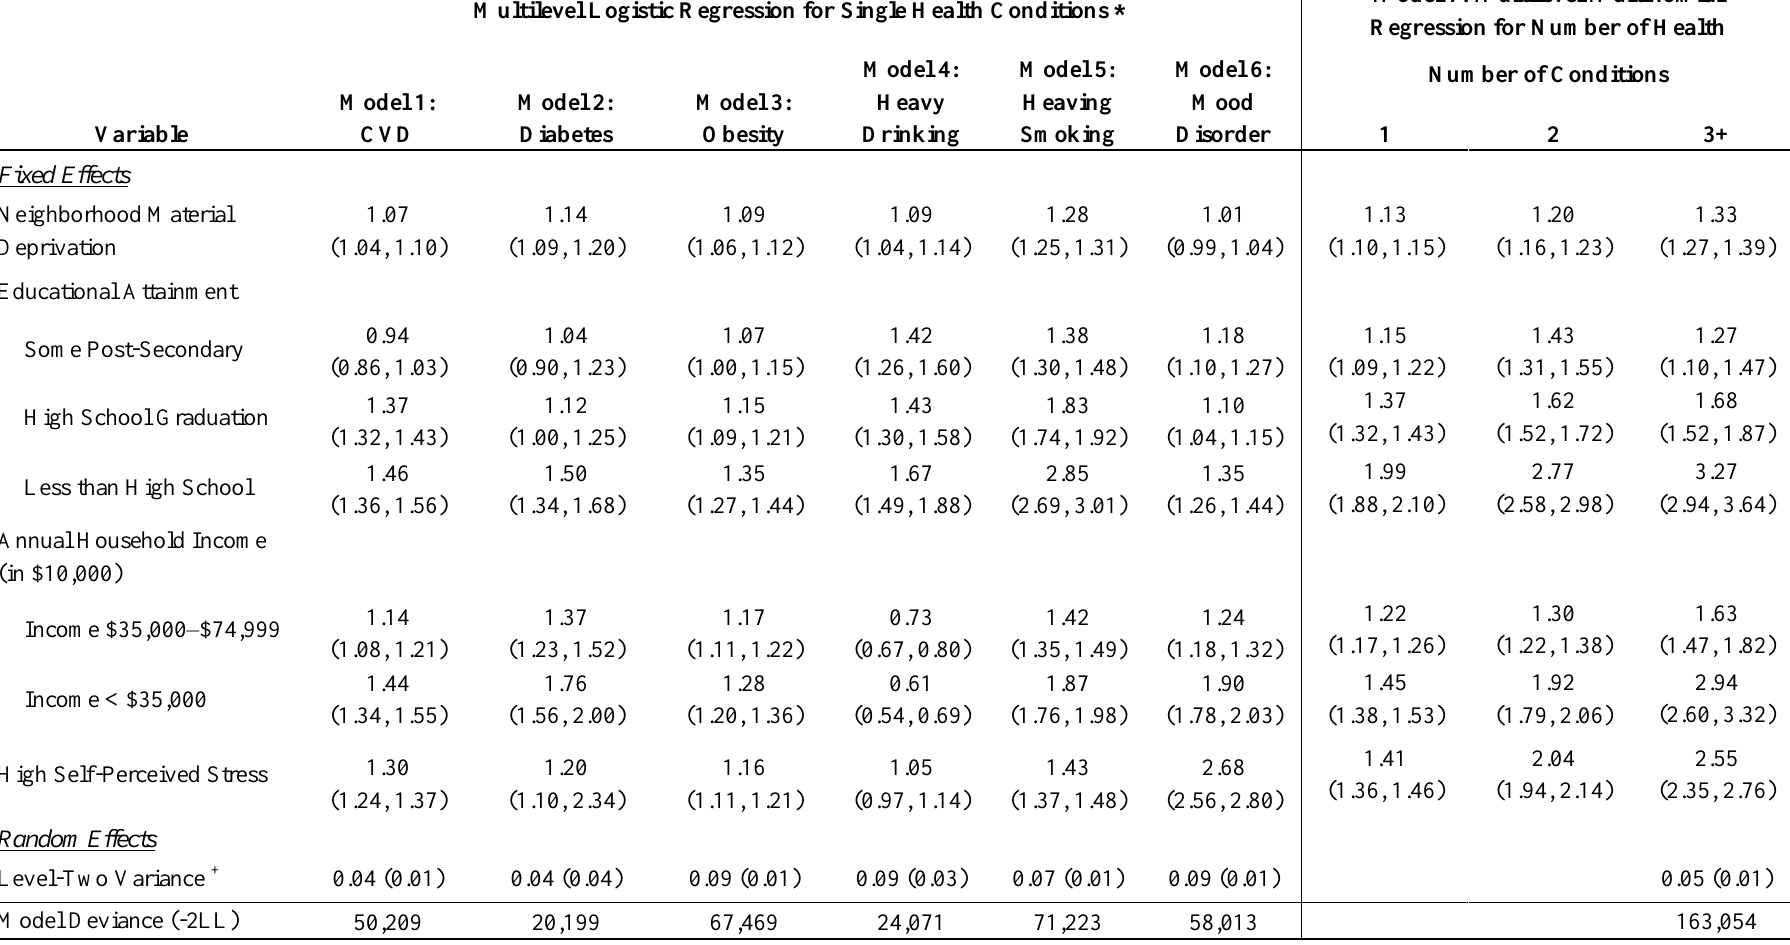
Table 2. Odds ratios of reporting single or compound health problems by neighborhood deprivation and socio-economic position. Canada 2000–2005 (n = 82,151). Multilevel Logistic Regression for Single Health Conditions *